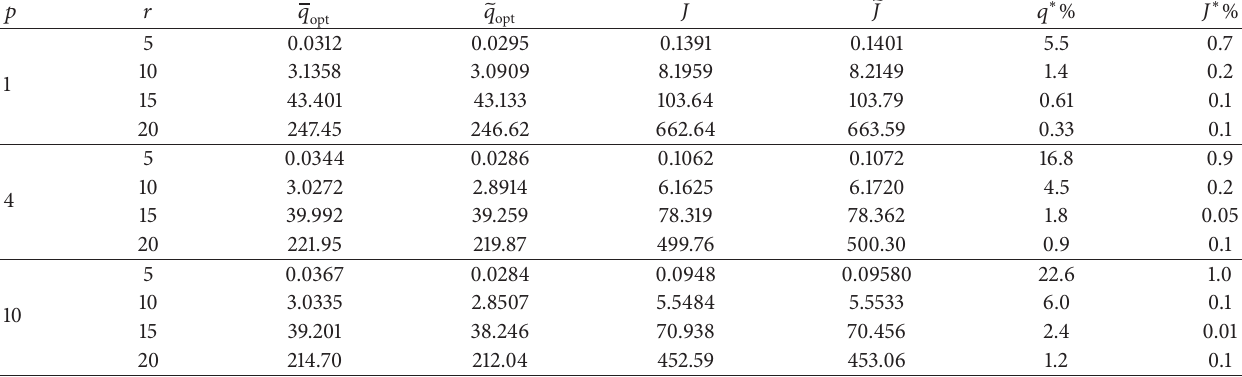
̃𝐽 , ̃𝑞 , 𝐽 , and of simply supported square Al/ZrO 2 FG plates with 𝑚 = 𝑛 = 1 . opt opt